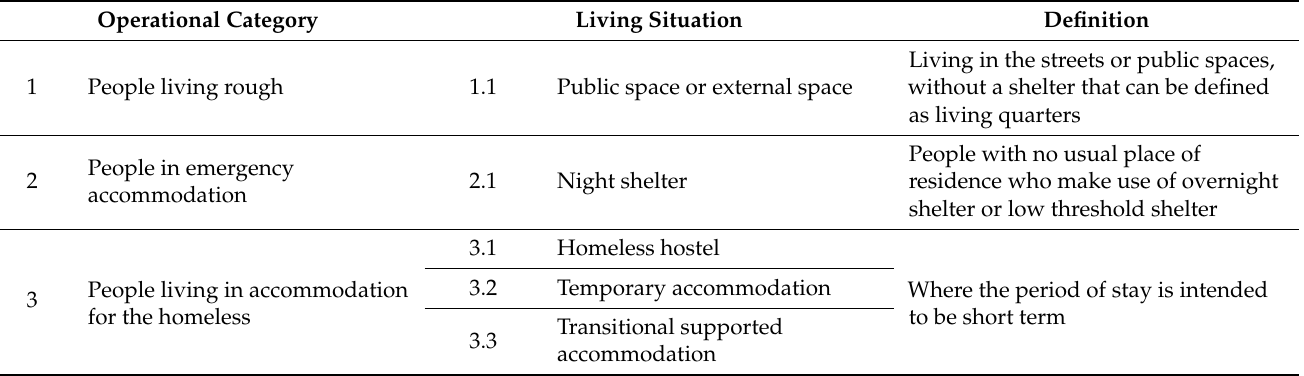
Table 1. Sampling inclusion criteria according to the ETHOS